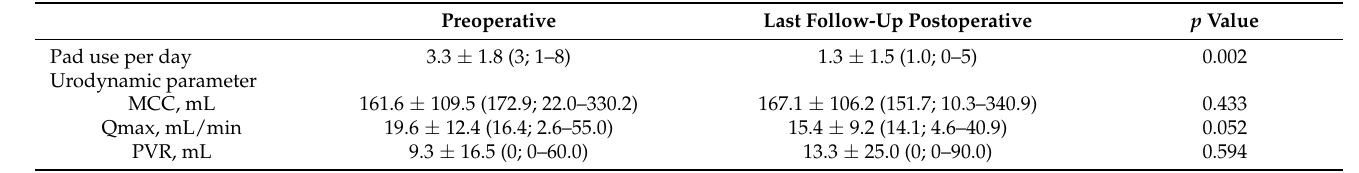
Table 2. Preoperative and last follow-up postoperative daily pad use and voiding